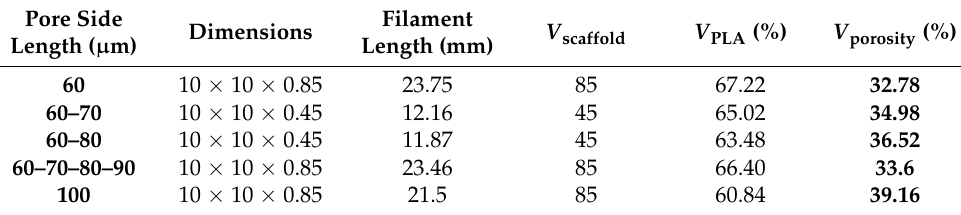
Table 1. Calculation of porosity volume for the various single and multi-layered PLA scaffolds. Pore Side Length ( µ